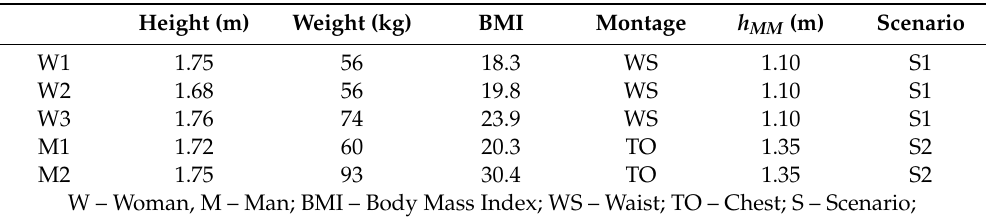
Table 2. Selected parameters of people participating in the measurements. Height